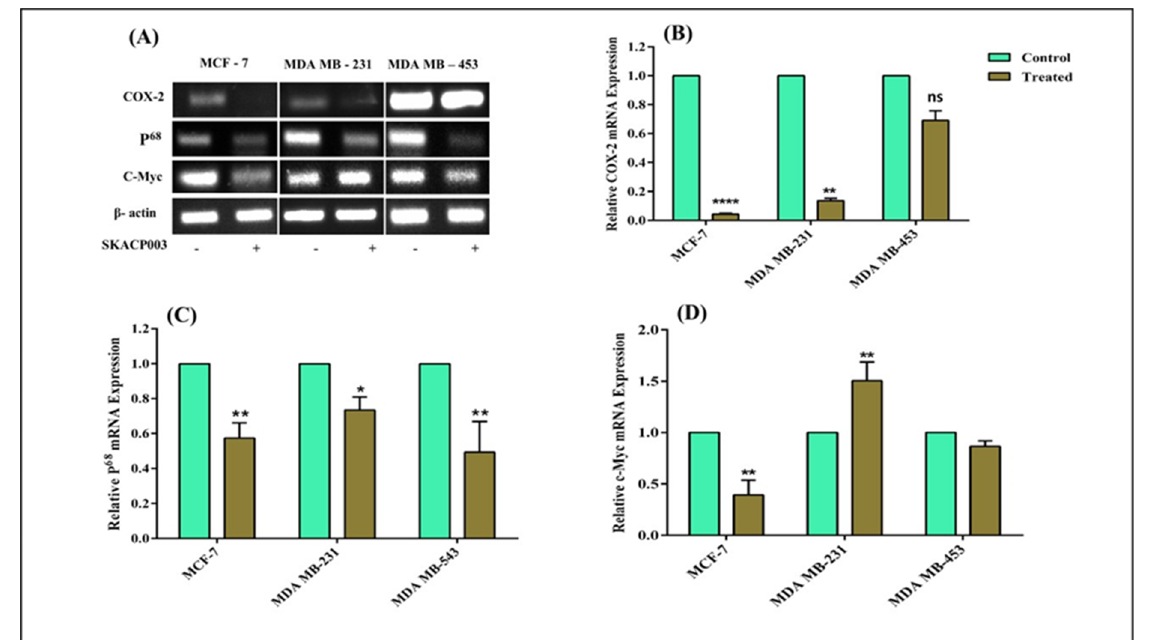
Figure 3. Downregulation of expressions of ( B ) COX ‐ 2, ( C ) P 68 , and ( D ) C ‐ Myc genes by SKACP003. The mRNA levels of COX ‐ 2, P 68 , and C ‐ Myc from total RNA were analyzed by RT ‐ PCR for the control and SKACP003 ‐ treated breast cancer cell lines of MCF ‐ 7, MDA ‐ MB ‐ 231, and MDA ‐ MB ‐ 453 ( A ). * = statistical significance at p < 0.05; ** = statistical significance at p < 0.01; **** = statistical significance at p < 0.0001; ns = not significant.